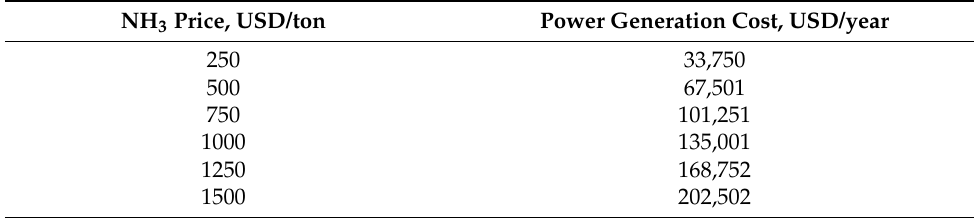
Table 12. Cost for the re-liquefaction system’s operation.